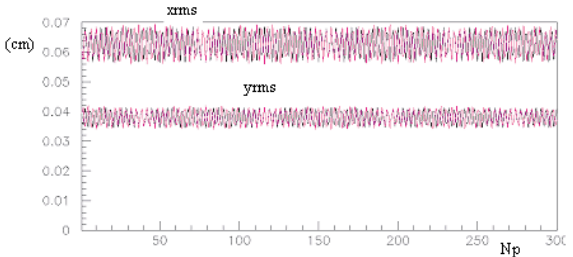
FIG. 8. (Color) The rms envelope oscillation damping with ini- tial K-V distribution for s (cid:5) s 0 (cid:2) 0.29 (cid:1) I (cid:2) 200 mA (cid:2) . The black line refers to the odd mode and the magenta line to the even